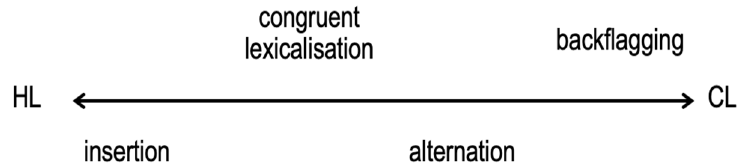
Figure 3. Intrasentential mixing strategies and thepresence of heritage and community languages (adapted from Muysken 2013, p. 715).